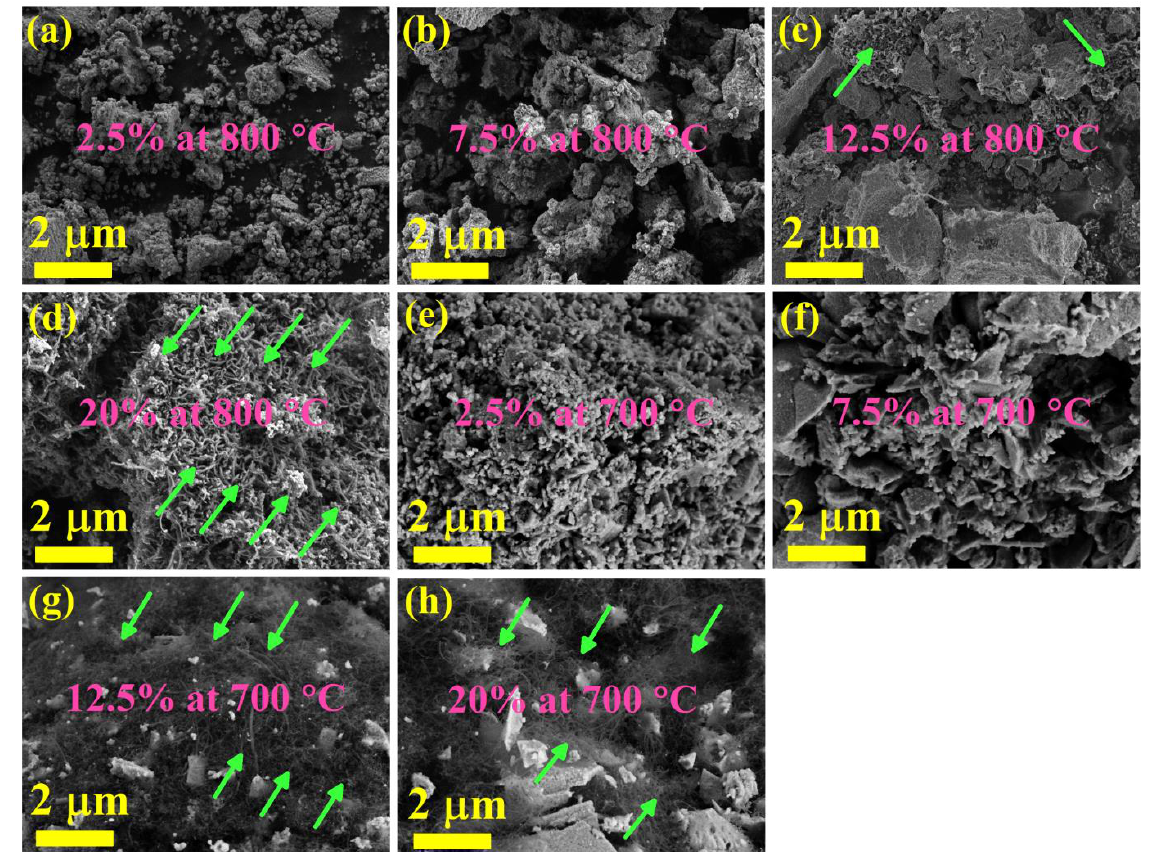
Figure 9. FESEM images of the Ni@CeO 2 catalysts prepared at different Ni-loadings (2.5, 7.5, 12.5, and 20 wt%) after operating the DRM reaction for 50.0 h at temperatures of 800 ◦ C ( a – d ) and 700 ◦ C ( e – h ). The green arrows refer to the carbon filaments deposited on the catalysts’ surfaces after the